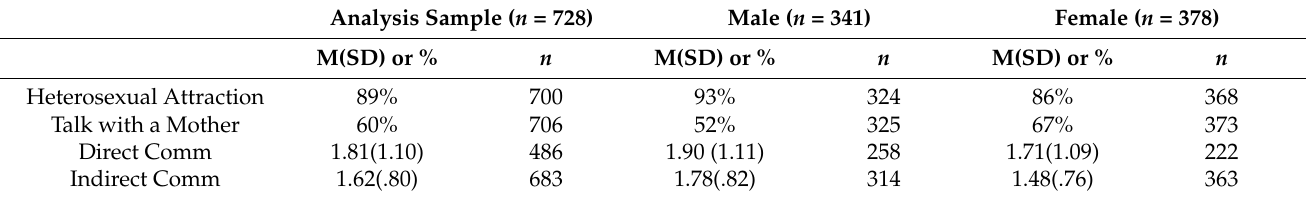
Table 3. Descriptive statistics for study